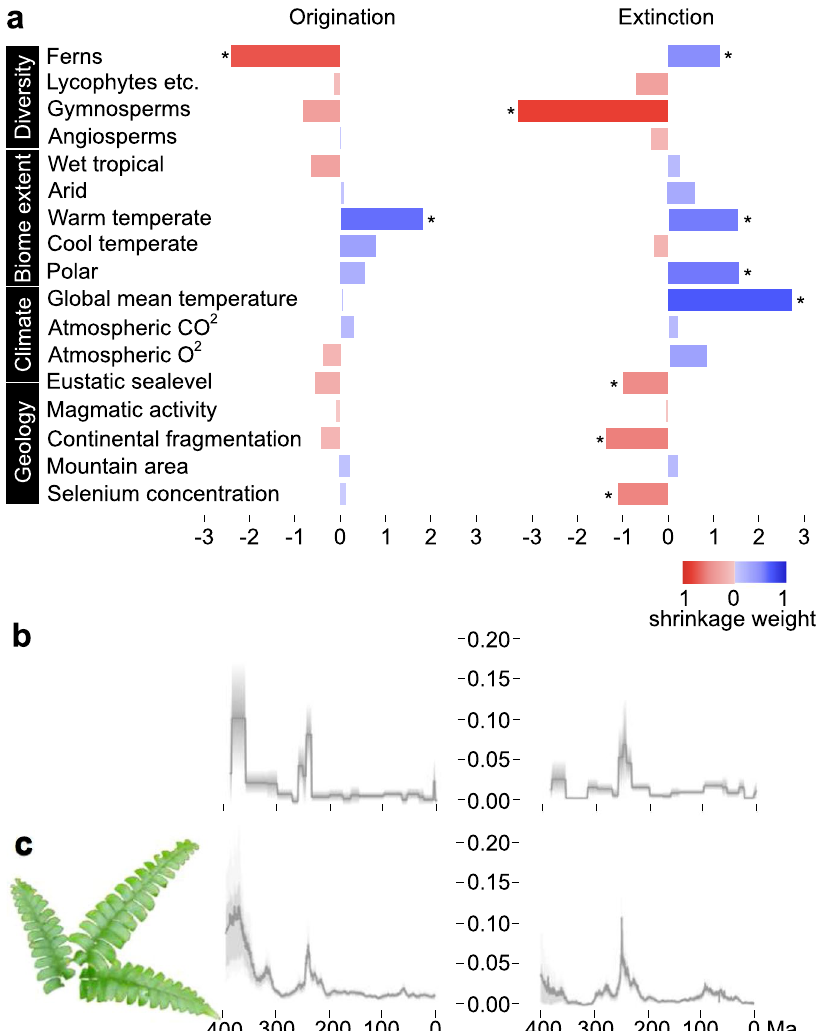
Figure 4. Paleoenvironmental correlates and diversification dynamics of ferns. ( a ) Correlation parameters (G i ) for fern originations and extinctions with darker colours indicating higher shrinkage weight (red for negative, blue for positive correlation). Significant correlations (shrinkage weight > 0.5) are indicated by asterisks. ( b ) Origination (left panel) and extinction (right panel) rates through time as estimated from the fossil record using the BDS model and ( c ) by the MBD model. The clear similarity between origination and extinction dynamics estimated under the two models indicate that the MBD model and the set of variables tested here can adequately recover the rates inferred under the BDS model disregarding potential Methods Modelling temporal variation in fossil diversity.